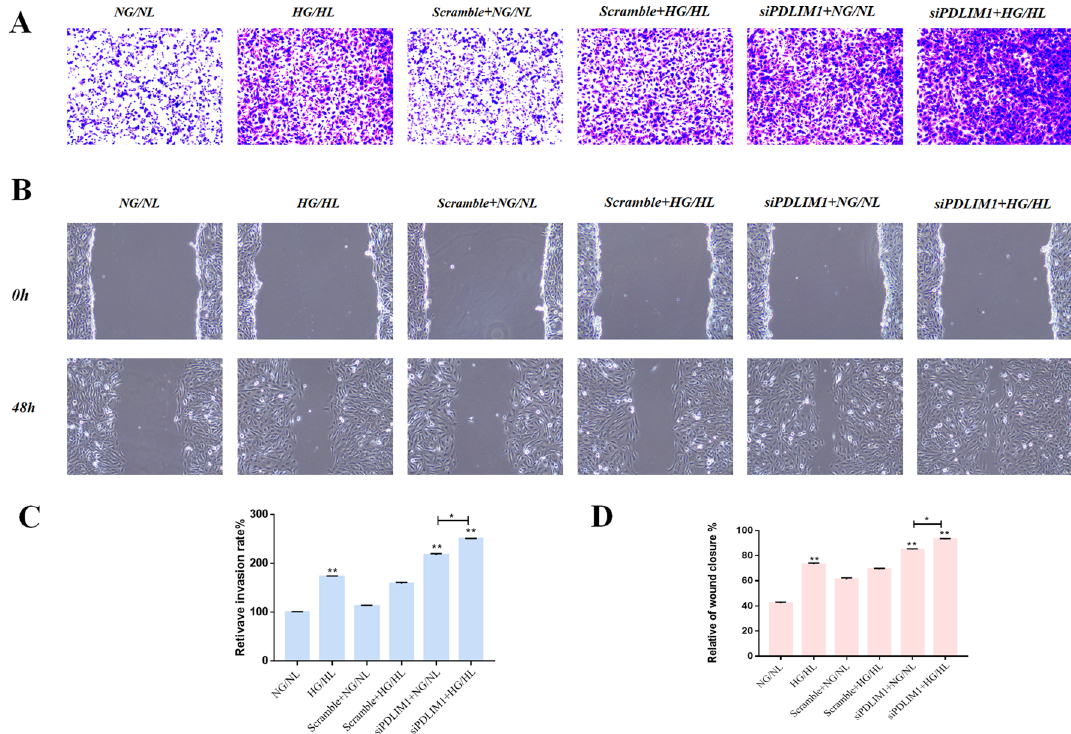
Figure 4. PDLIM1 inhibits the invasion and migration of retinal capillary endothelial cells (RCECs). ( A ) Transwell was used to compare the invasion of RCECs 24 h after HG/HL and PDLIM1 transfection. Scale bar: 50 μm ( B ) The migration of RCECs 48 h after HG/HL and PDLIM1 transfection was compared by scratch test. Scale bar: 50 μm. ( C ) The invasion of cells increased after HG/HL treatment compared with NG/NL. The invasion of RCECs was enhanced after PDLIM1 knockdown, compared with Scramble control. ( D ) The migration of cells increased after HG/HL treatment compared with NG/NL. The migration of RCECs was promoted after PDLIM1 knockdown, compared with Scramble control. **P <